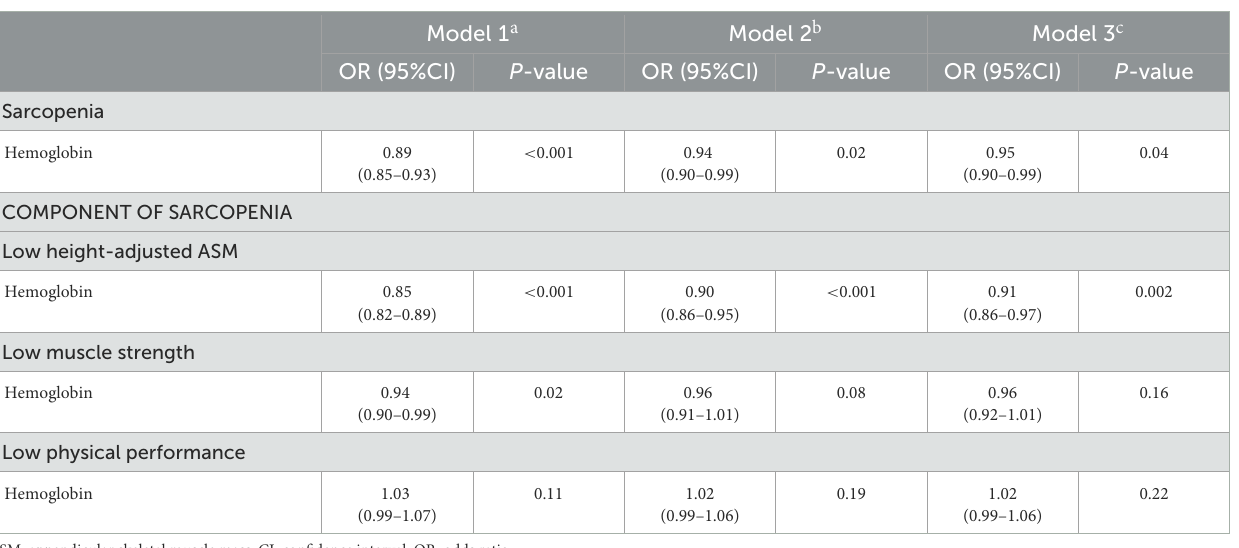
TABLE 2 Cross-sectional associations among hemoglobin, sarcopenia, and sarcopenia components in baseline year